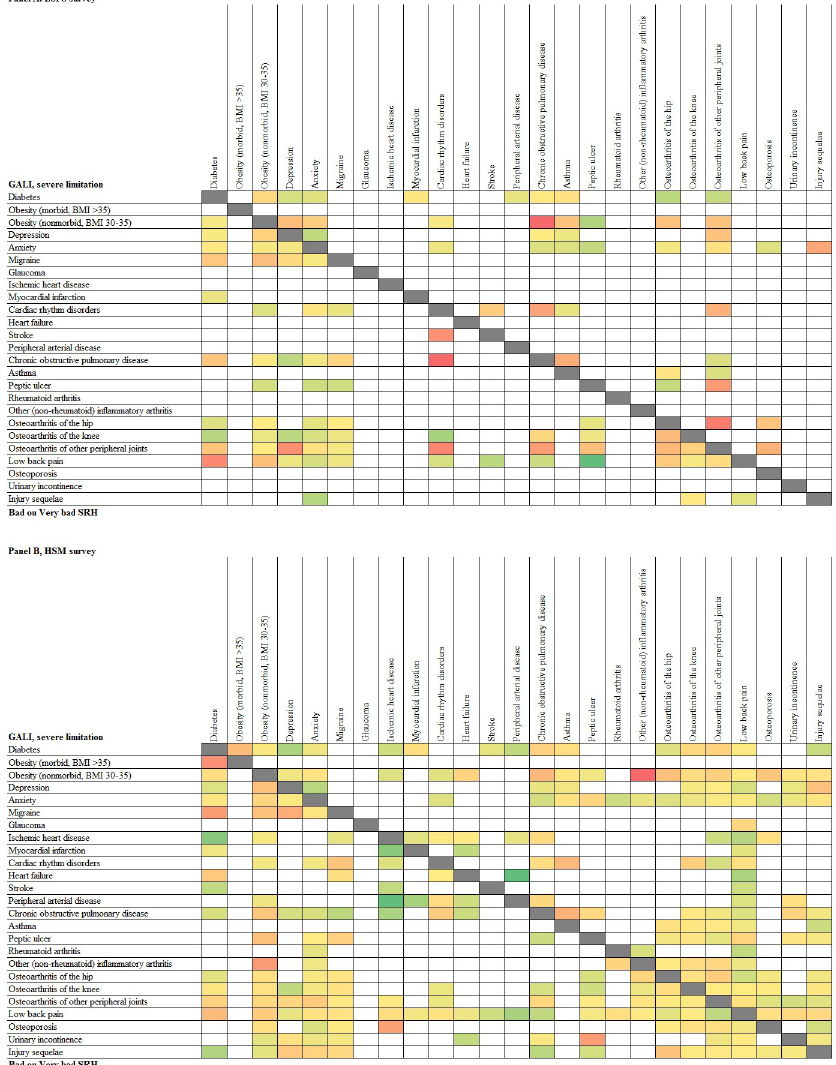
Fig 5. Interactions between the associated conditions in dyads on activity limitations (severely limited in GALI, upper right panel above the diagonal) and perceived health (bad or very bad SRH, lower left panel below the diagonal) in ESPS (Panel A) and HSM surveys (Panel B). Interactions are evaluated by the RERI (see S8 Table for values) and represented using a color scale from green (low values: subadditive or additive) to red (high values: multiplicative or supermultiplicative). Only dyads with a frequency of � 0.25% in at least 1 survey sample are considered. BMI, body mass index; ESPS, Enqu ê te Sante´ et Protection Sociale; GALI: Global Activity Limitation Indicator; HSM, Enqu ê te Handicap–Sante´ Me´nages; RERI, relative excess risk due to interaction; SRH: Self-Reported Health indicator.